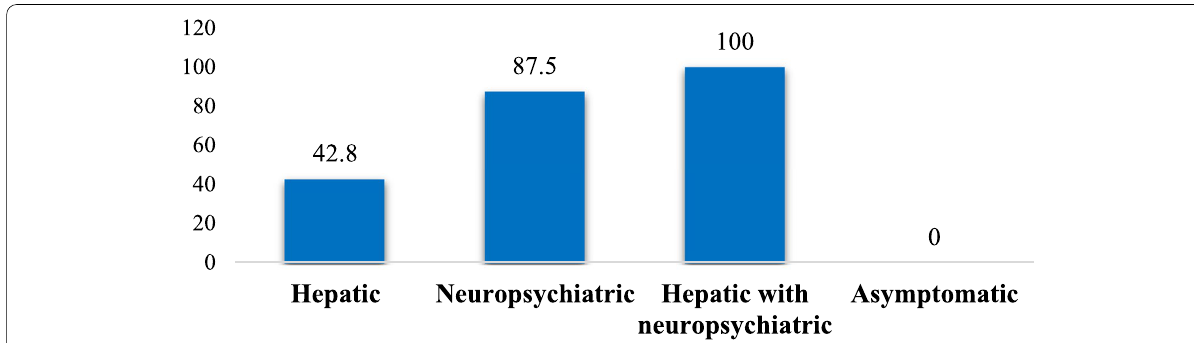
Fig. 4 KF ring in the studied children ( n